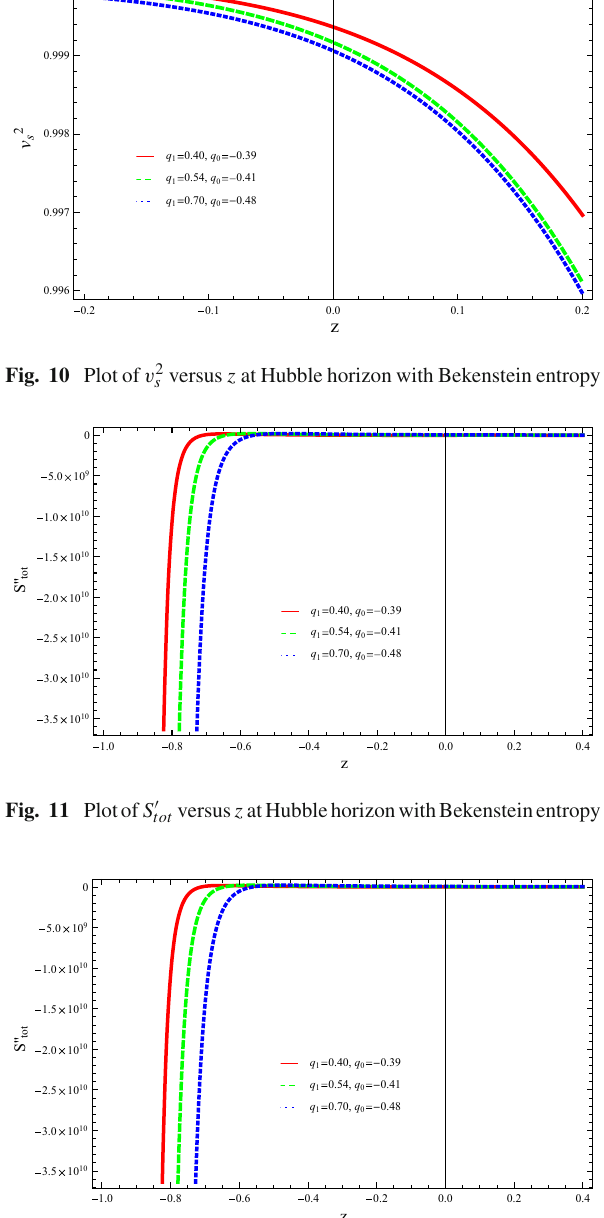
and green trajectory confirms the thermal equilibrium con- dition at z ≥ − 0 . 2 . Thus the thermal equilibrium condition satisfies for z ≥ − 0 . 01 (blue trajectory) and for z ≥ − 0 . 2 (red and green trajectory) at Hubble horizon.